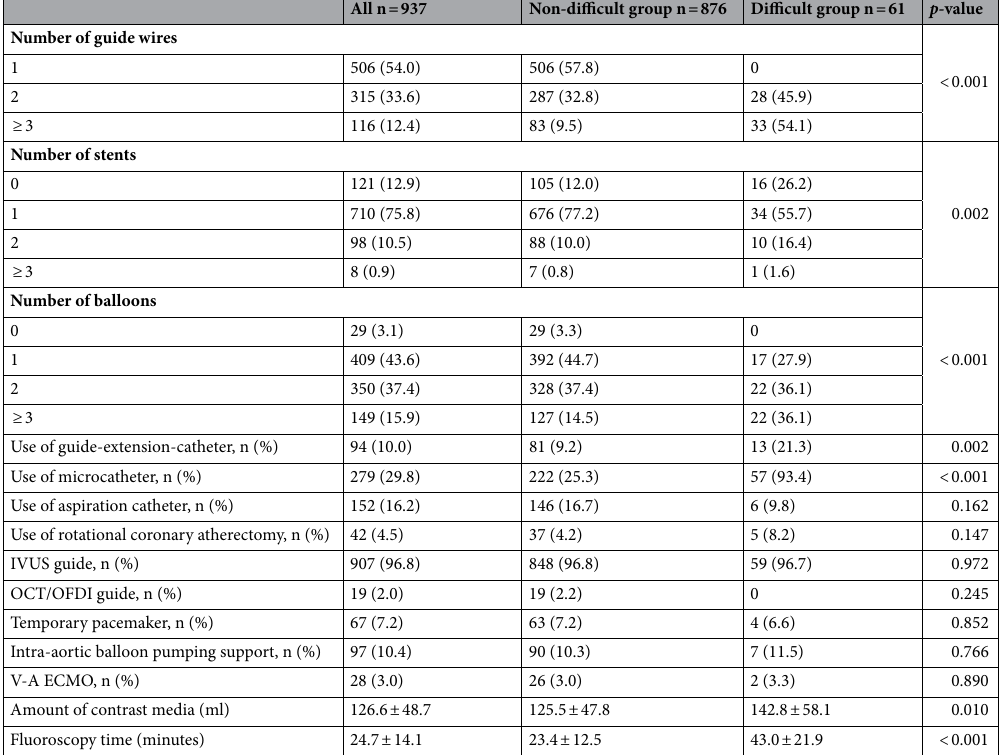
Table 1. Comparison of patient’s characteristics between the non-difficult group and the difficult group. Data are expressed as the mean ± SD or number (percentage). A Student’s t test was used for normally distributed continuous variables, a Mann–Whitney U test was used for abnormally distributed continuous variables, and a chi-square test was used for categorical variables. PCI indicates percutaneous coronary